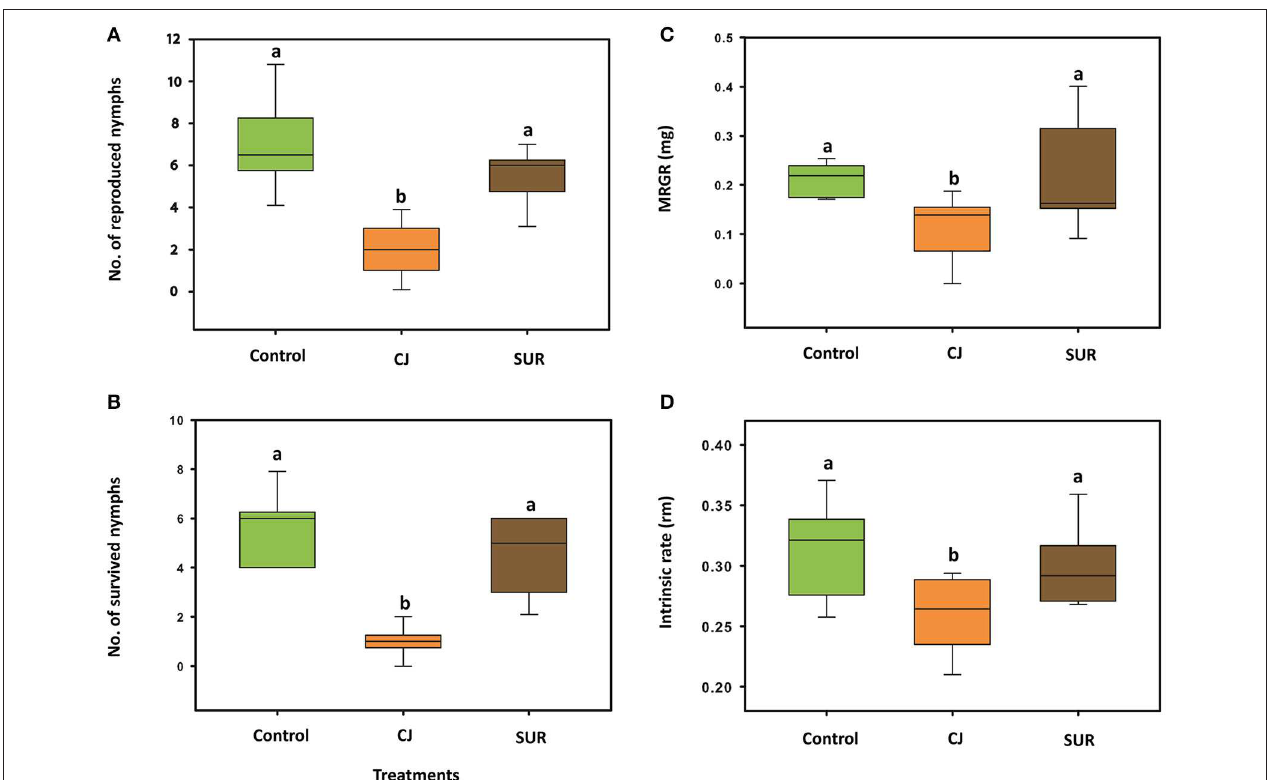
FIGURE 2 | Performance of Macrosiphum euphorbiae on treated potato plants. Control = non-sprayed plants, CJ = cis -jasmone-sprayed plants and SUR = surfactant-sprayed plants. (A) Mean ( ± SE) no. of reproduced nymphs 24h after infestation. (B) Mean ( ± SE) no. of survived nymphs after 7 days. (C) Mean relative